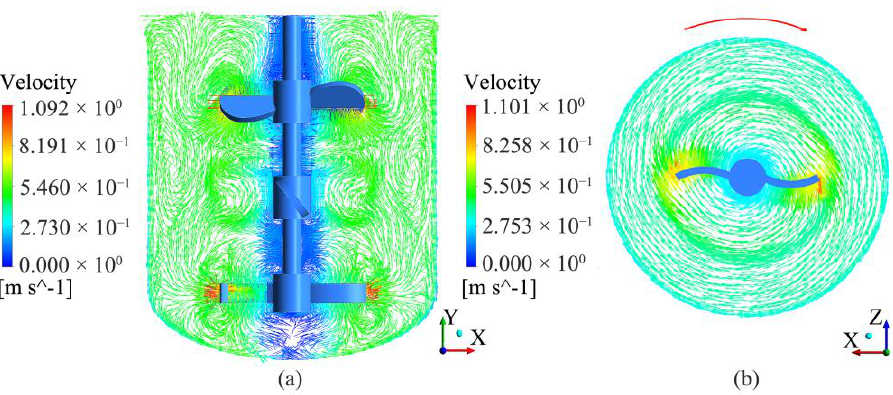
Figure 8. Velocity vector diagram when the medium is water and Re = 44,910. ( a ) TBC-B type agitator, Plane 1:XY,Z = 0 mm; ( b ) TBC-B type agitator, Plane 3:XZ,Y = 70 mm.